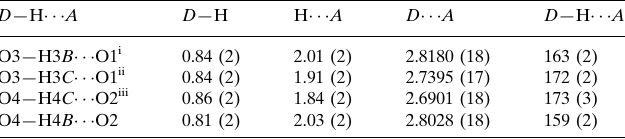
Hydrogen-bond geometry (A˚ , (cid:3)